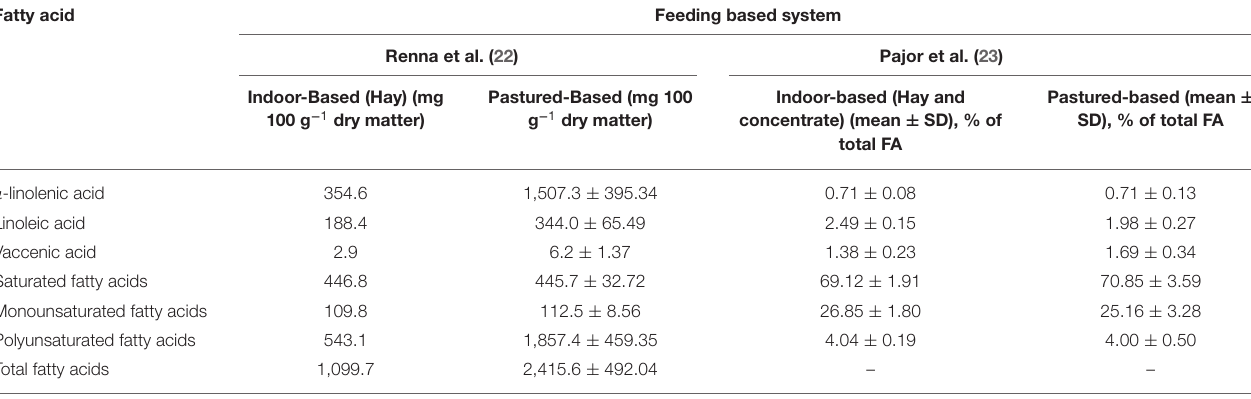
TABLE 1 | Comparison of fatty acid composition of goat milk based on pasture-based and indoor based feeding system. Fatty acid Feeding based system